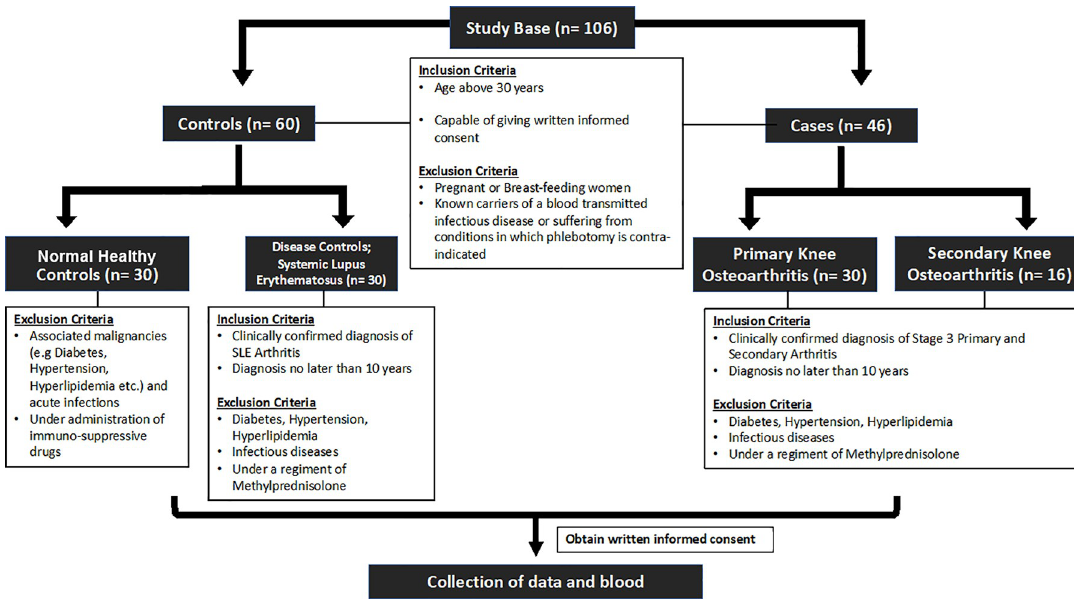
Fig 1. Scheme of the case control study